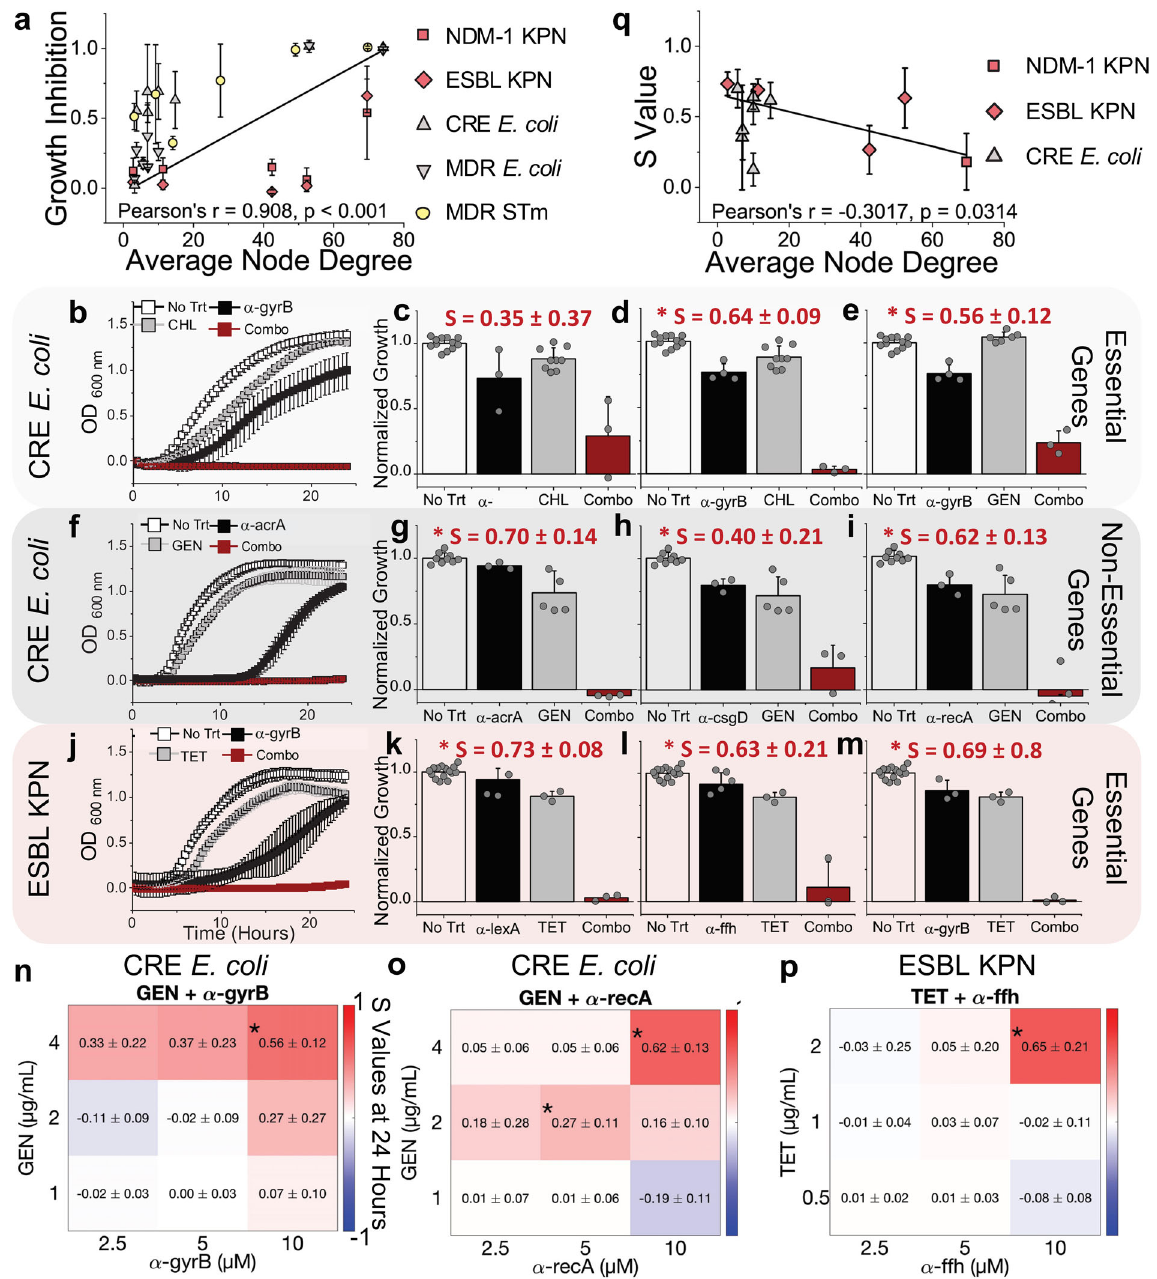
Fig. 3 FAST platform generates PNAs that can potentiate activity of traditional small molecule antibiotics. a Using the STRING database of protein network interactions (data shown in Supplementary Figure S10), we found a positive correlation, Pearson ’ s r = 0.908 and p < 0.001, between growth inhibition of PNA homologous with target bacteria and average node degree, the number of interactions of protein has in the average network. b – m Subsequent growth curves and bar plots show bacteria without treatment, or treatment with PNA alone (10 µ M), or antibiotic alone, or PNA and antibiotic combined. Antibiotic concentrations were (from top to bottom) 2 µ g/mL tetracycline (TET), 4 µ g/mL gentamicin (GEN), and 8 µ g/mL chloramphenicol (CHL). b, f, j The fi rst column shows representative growth curves over 24 h of each treatment. Panels b – e and f – i show treatment of CRE E. coli with PNAs targeting essential and non-essential genes respectively. Panels j – m show treatment of ESBL KPN with PNAs targeting essential genes. All bar plots are the average OD (600 nm) of each treatment at 24 h normalized to no treatment at 24 h. S values above the bar plots were obtained using the Bliss Independence model and indicate synergistic interaction between PNA and antibiotic at 24 h, an asterix indicates signi fi cance at α = 0.05. Grey circles indicate individual biological replicates. Panels n – p show select heat maps of synergy values at 24 h of checkerboard combination assays (Figures S12-13). q Plotting the S values representing synergy against the target protein ’ s average node degree shows a negative correlation (Pearson ’ s r = − 0.3017, p = 0.0314). All data shown are the average of at least three biological replicates with standard deviation shown as error